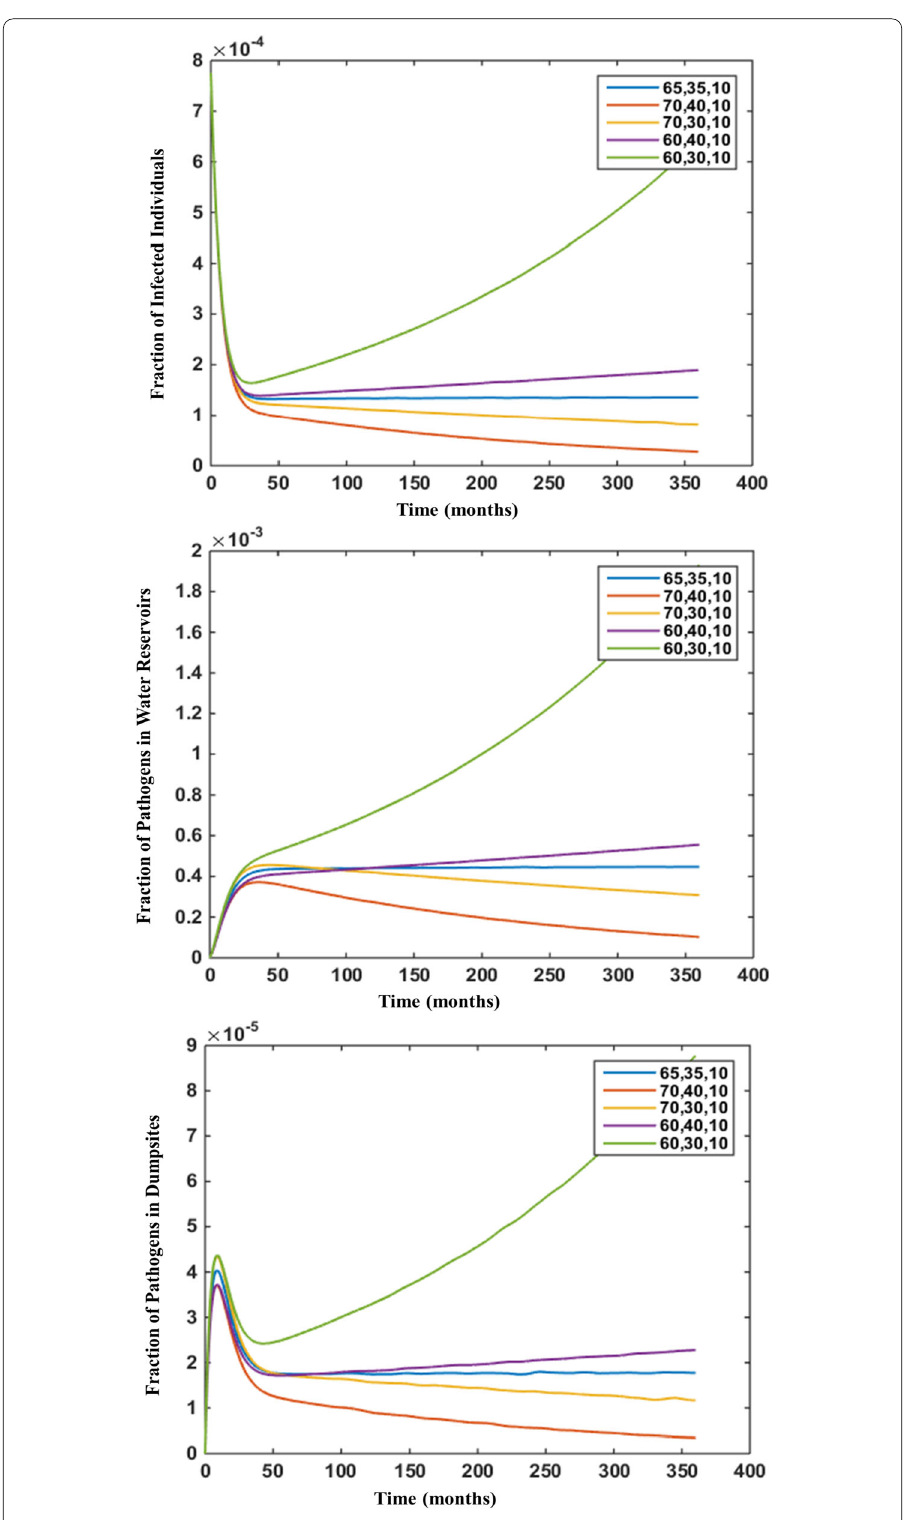
Figure 8 Effects of improving DWS and WST services coverage ( r 1 and r 2 ) on the fraction of infected individuals and the fraction of pathogens in water reservoirs and dumpsites that are predicted by model